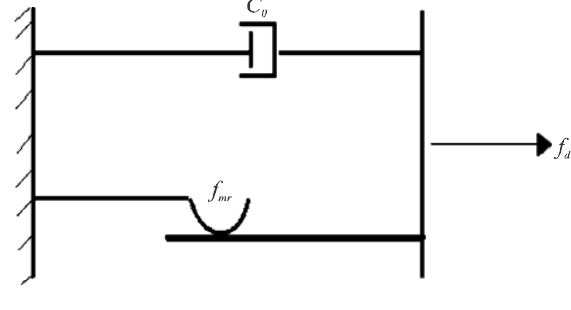
FIG. 1. RHEOLOGICAL STRUCTURE OF AN MR DAMPER FOR BINGHAM